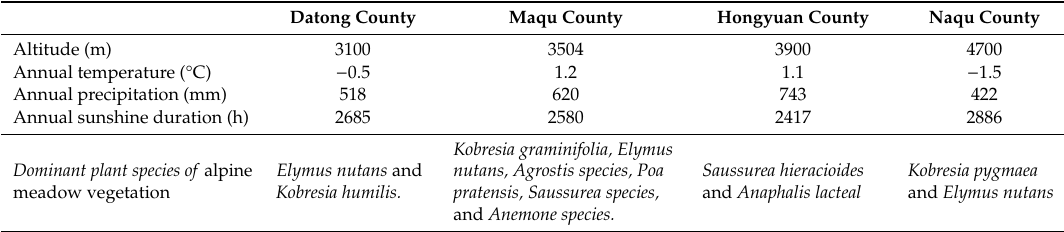
Figure 2. Details of the sampling sites (a: Datong County, b: Hongyuan County, c: Maqu County, and d: Naqu County). Table 1. Comparisons of the environmental, ecological, and behavioral data of the animals selected at the experimental sites.